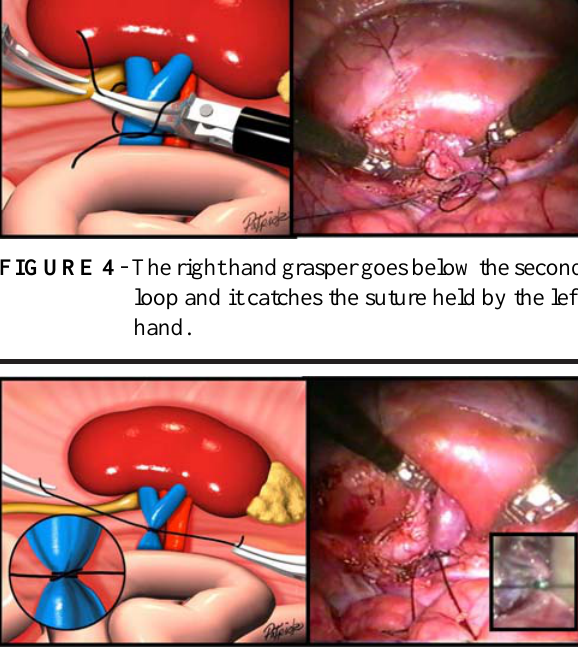
FIGURE 5 - Both graspers pull the suture constantly until venal occlusion is